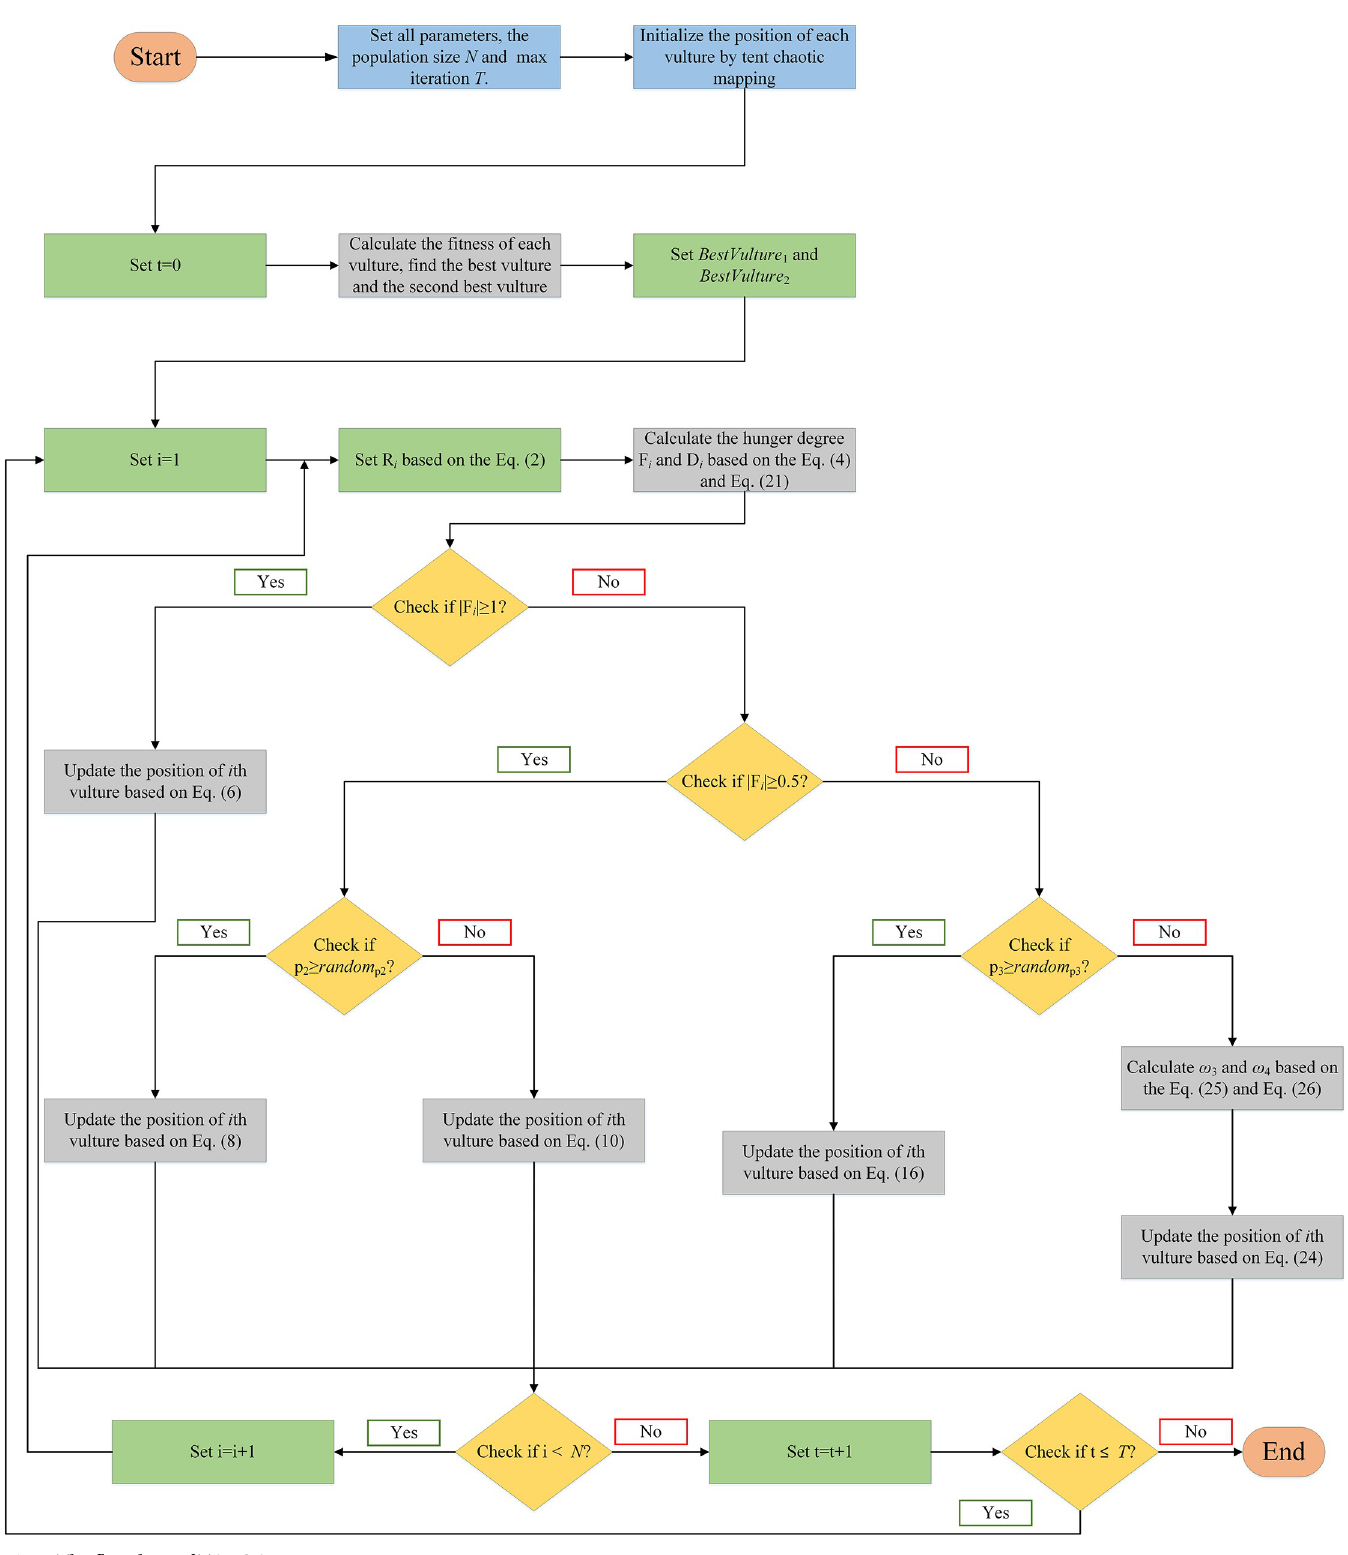
Fig 6. The flowchart of TAVOA.